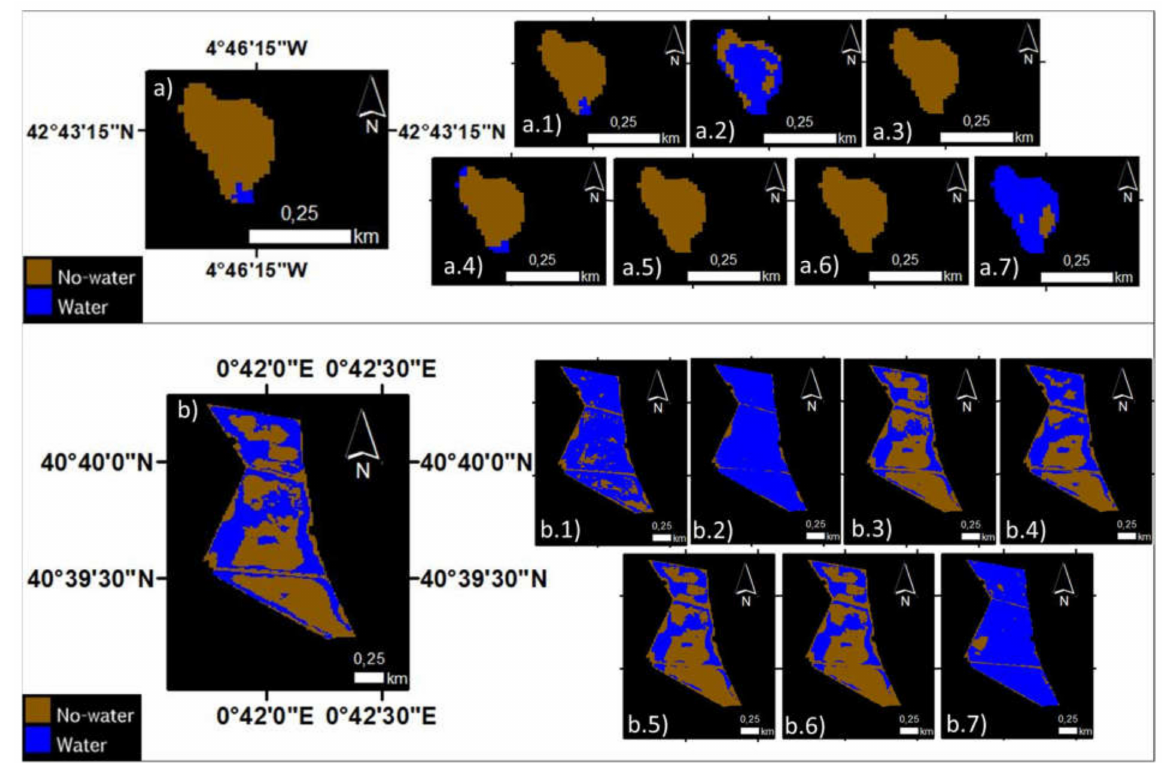
Figure 6. Results of the classification (right) from the GP0.1 ( a.1 , b.1 ), GP-0.05 ( a.2 , b.2 ), NDWI ( a.3 , b3 ), AWEInsh ( a.4 , b.4 ), AWEIsh ( a.5 , b.5 ), WRI ( a.6 , b.6 ) and WTI ( a.7 , b.7 ) for ( a ) Laguna de Campillo and ( b ) Filtre Biologic l’Embut for the Sentinel image dates of 30 August 2019 and 15 June 2017, respectively, and the reference dates (left) of 30 August 2019 ( a ) and 14 June 2017 ( b ),